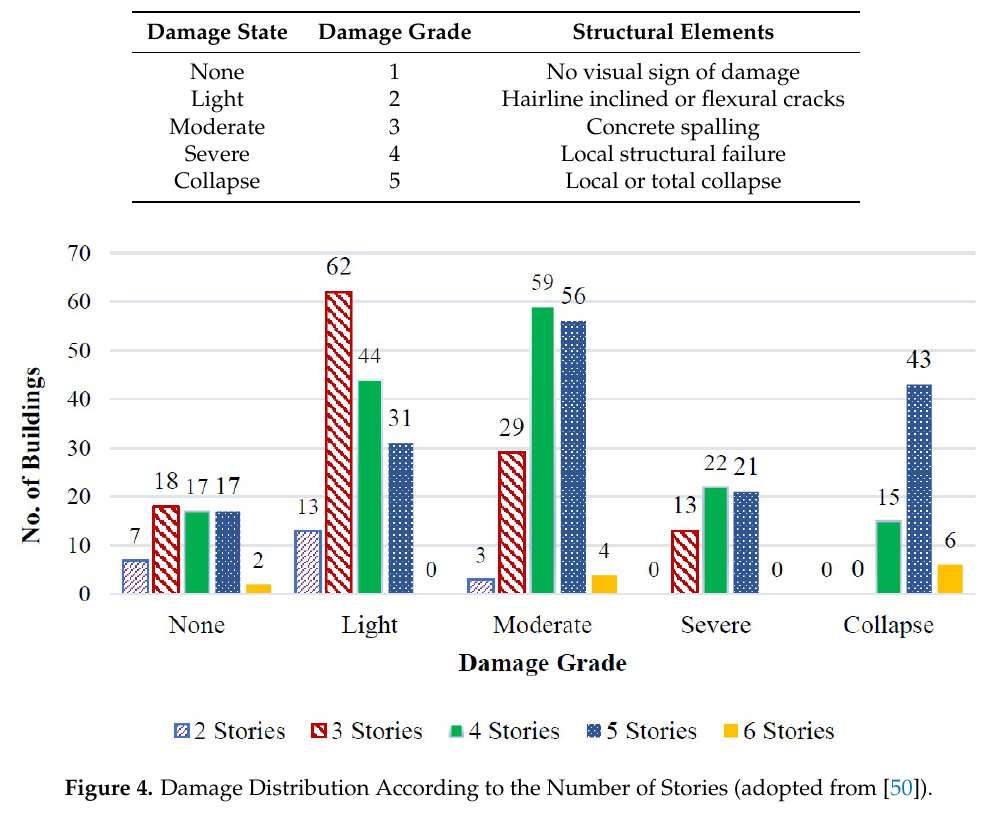
Table 2. Description of Damage.